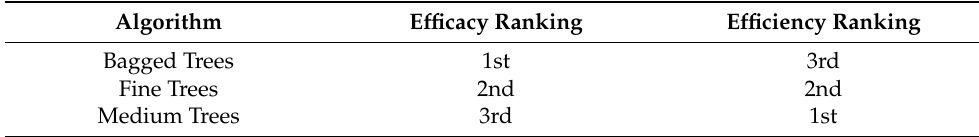
Table 4. Efficacy vs. Efficiency